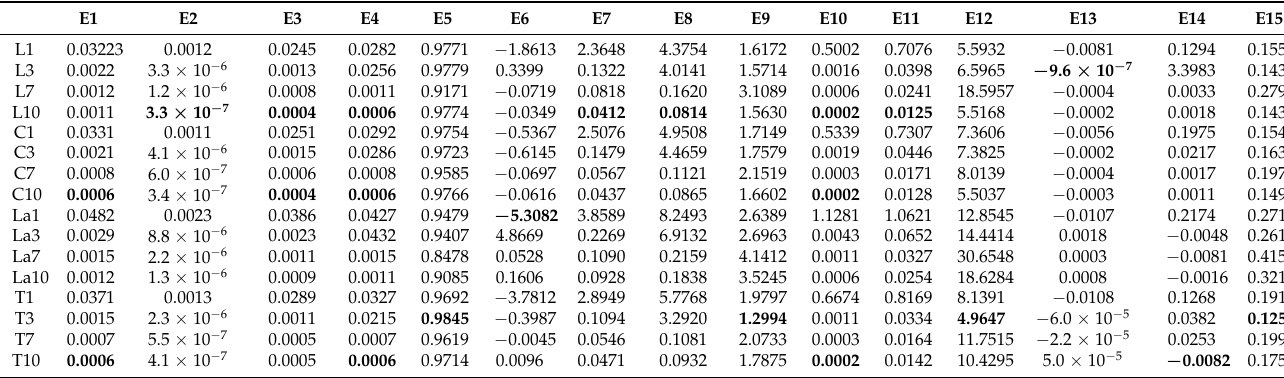
Table 13. Error values in testing 16 predictor models for Bitfinex dataset.